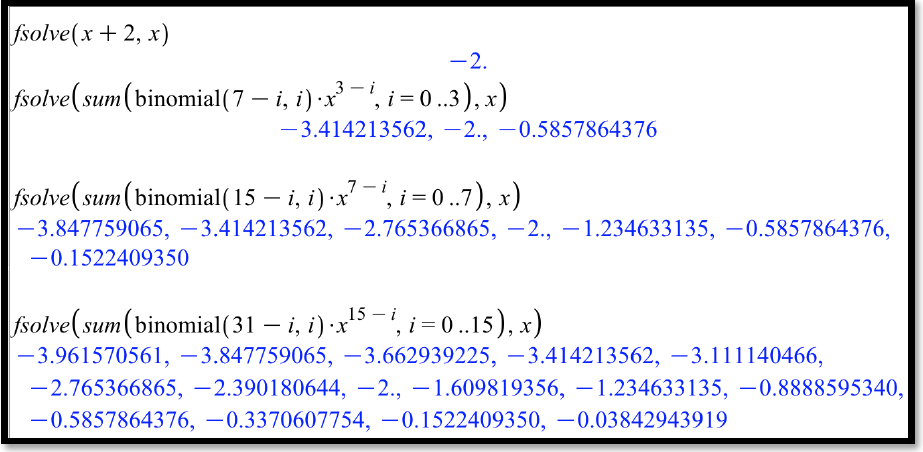
Figure 7. ROAs and LOAs of the root of 𝑃 2 (𝑥) = 𝑥 + 2.